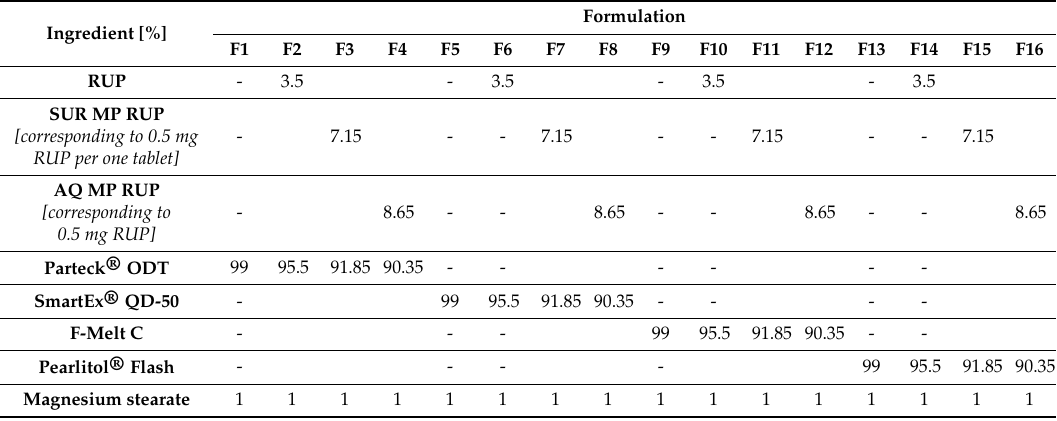
Table 1. Composition of orodispersible minitablets (ODMT)